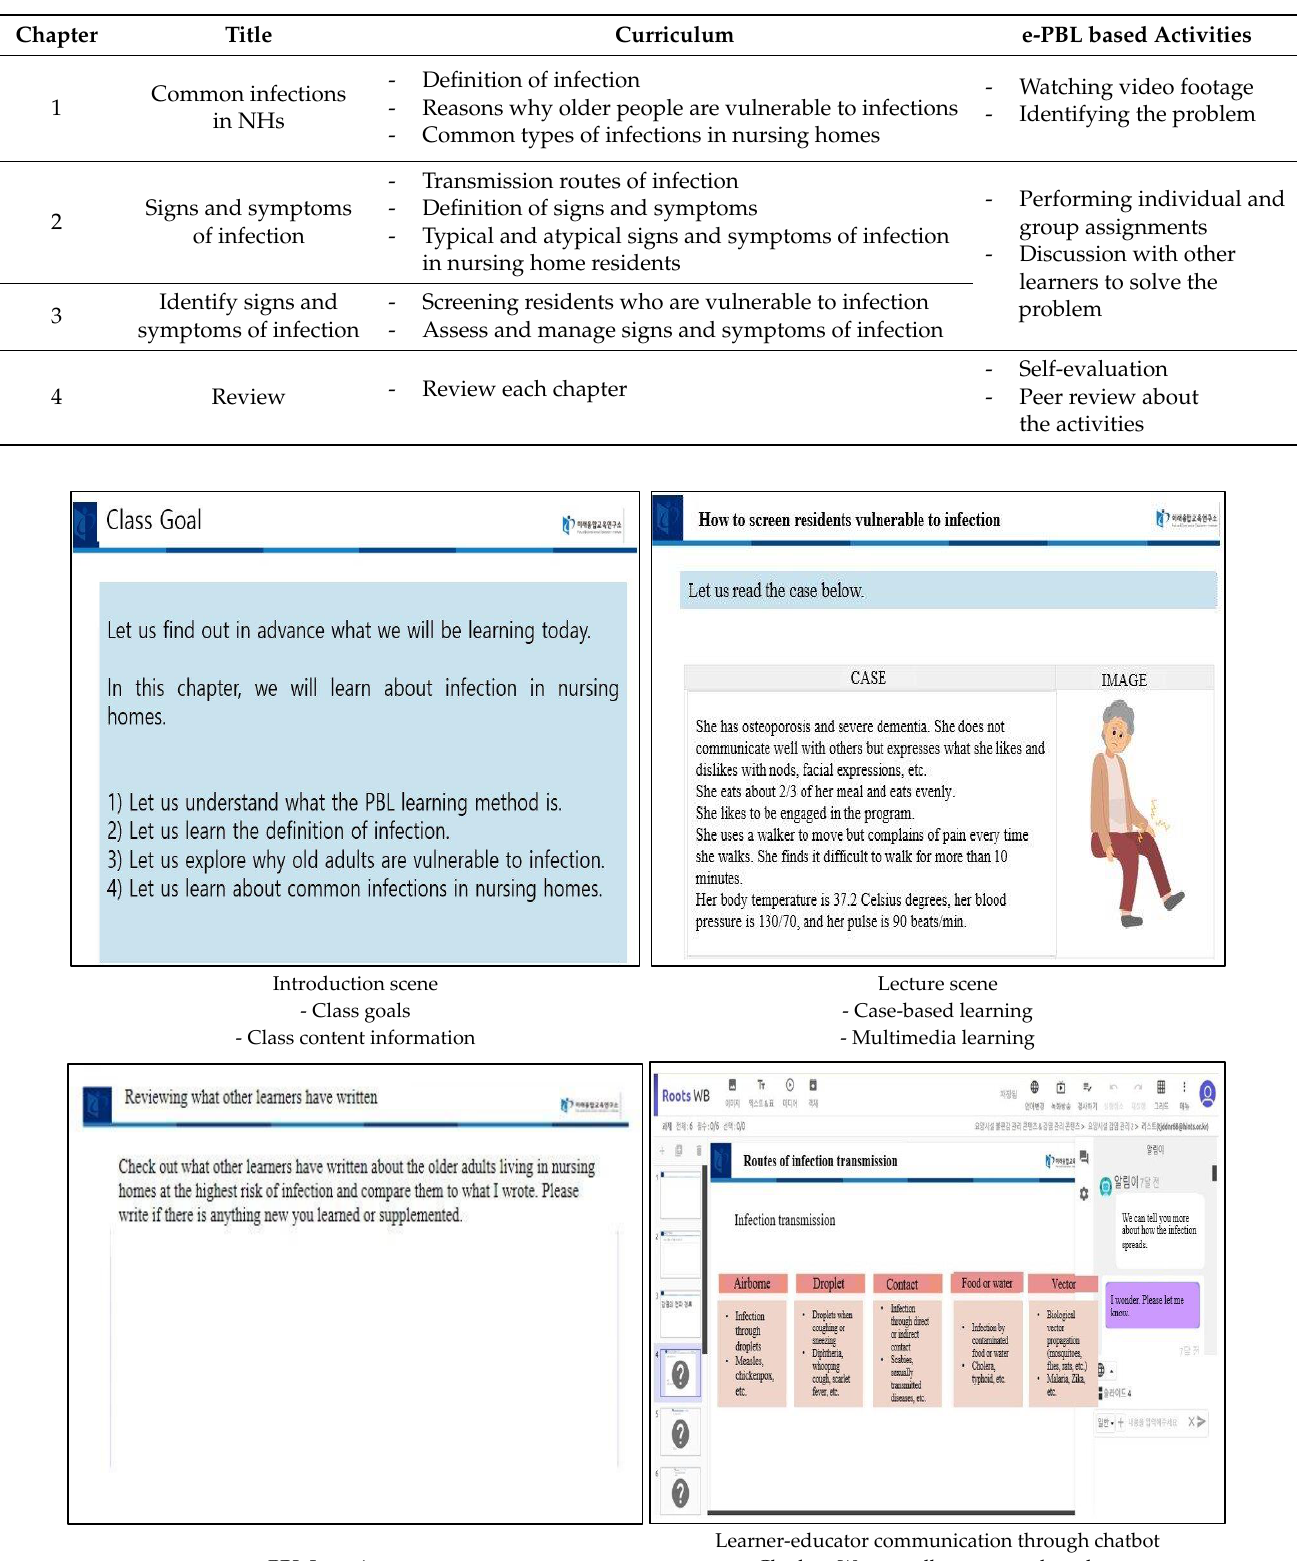
Table 1. Course for the infection control educational program for NH staff.